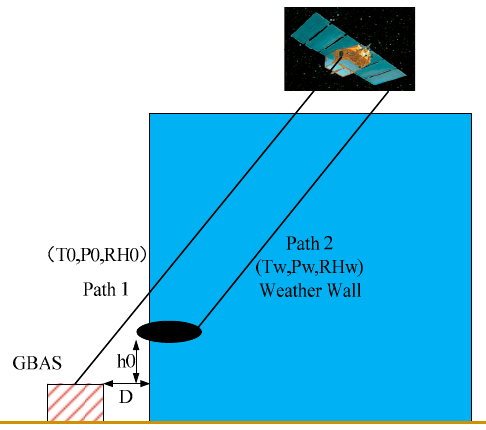
Figure 8. Weather wall model.